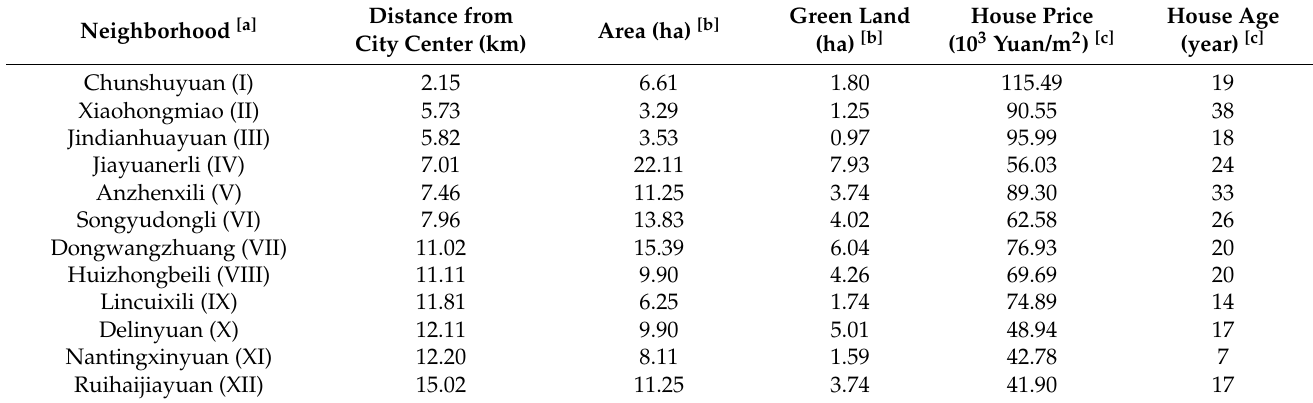
Table 1. Basic information of neighborhoods